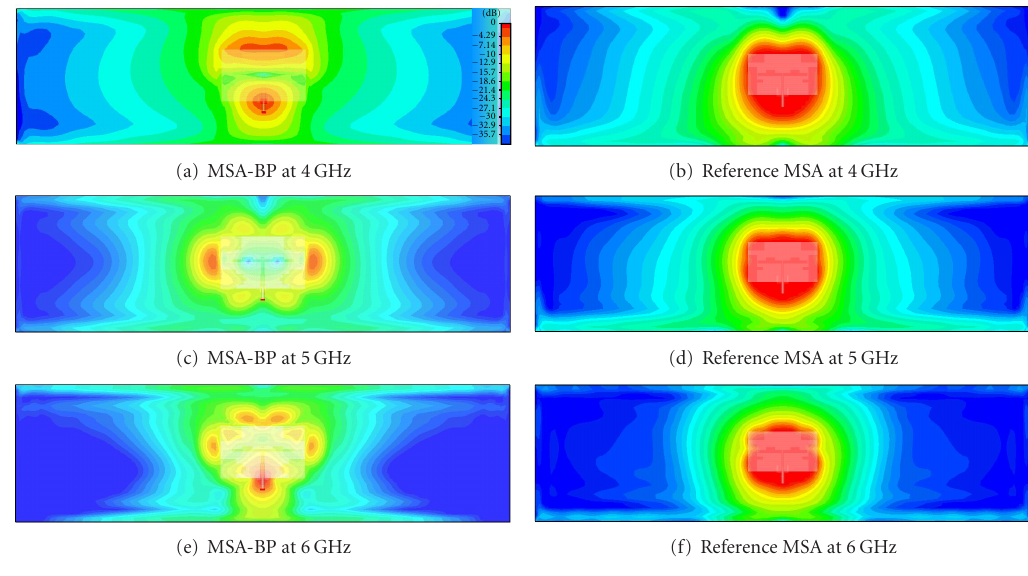
Figure 14: Power absorbed in the body, for the MSA-BP and the MSA.